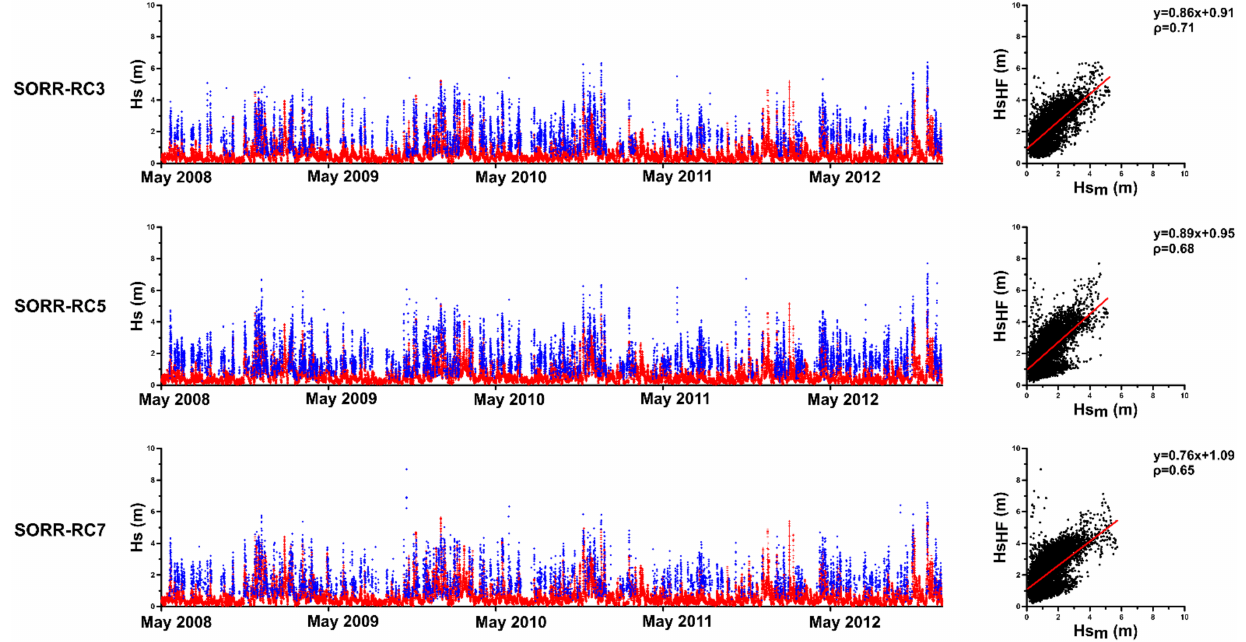
Figure 2. ( left ) Time series comparison of wave heights (Hs) between SORR HFr (blue) and MWM (red) from RC3, RC5 and RC7 (upper, middle and lower panel, respectively). ( right ) Scatter plots of Hs values recorded by the HFr and retrieved by using the MWM model at the three RCs.